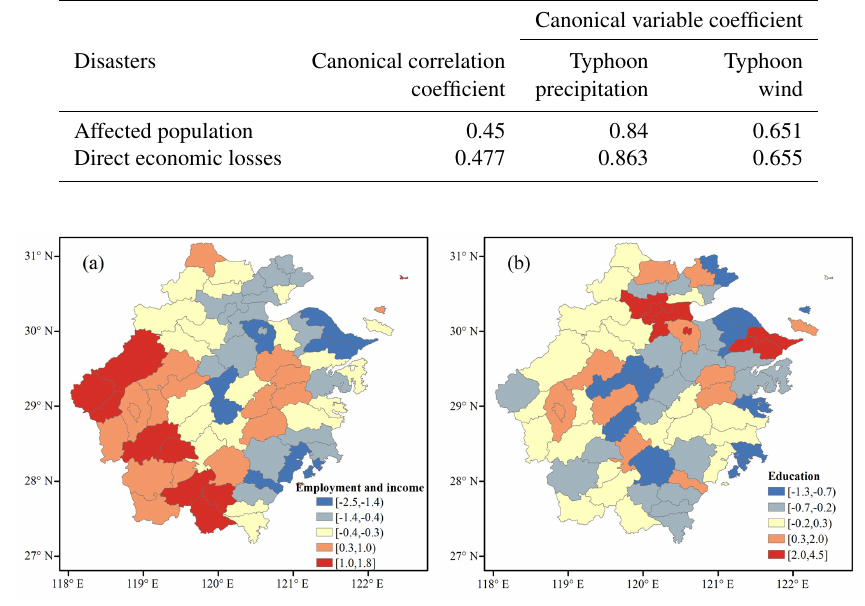
Figure 9. Distribution of population vulnerability index of (a) component 1 (employment and income) and (b) component 2 (education).